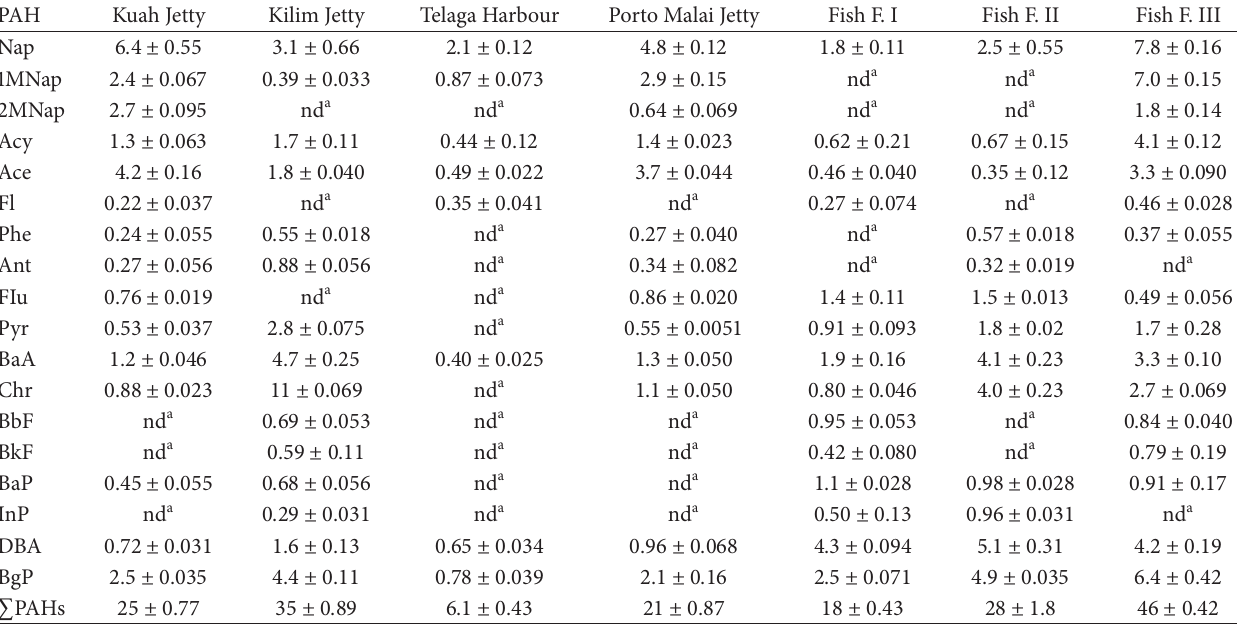
Table 2: Concentrations of 18PAHs in the seawater around Langkawi Island ( 𝜇 gL − 1 ).